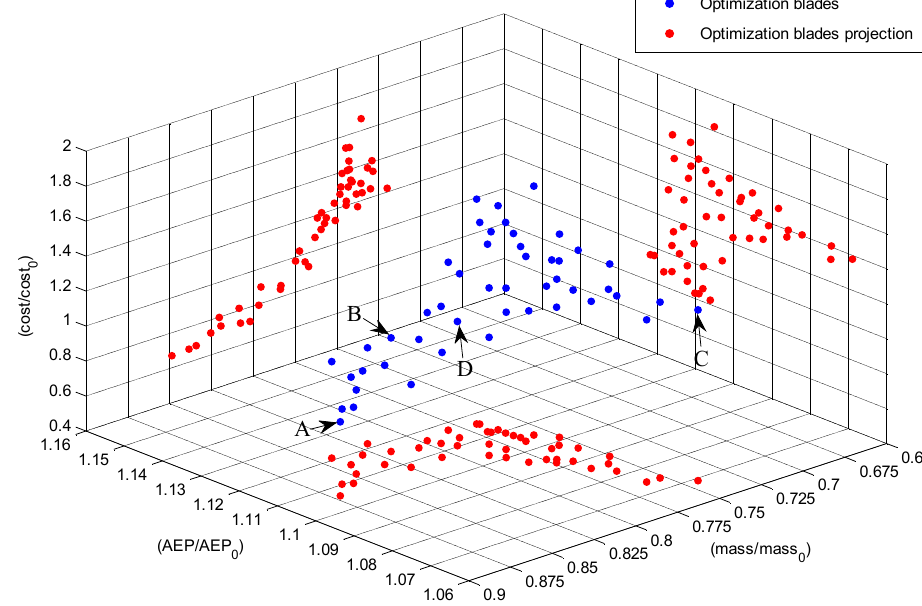
Figure 12. Pareto front of the objectives. AEP : annual energy production.